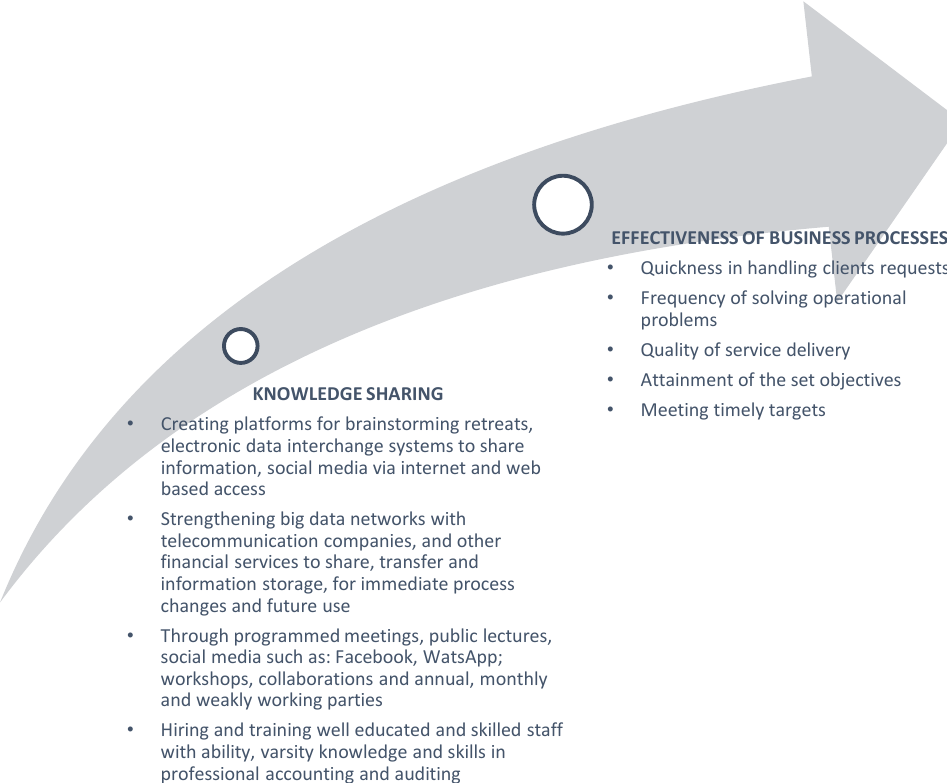
Figure 2. Double loop of knowledge sharing of microfinance institutions